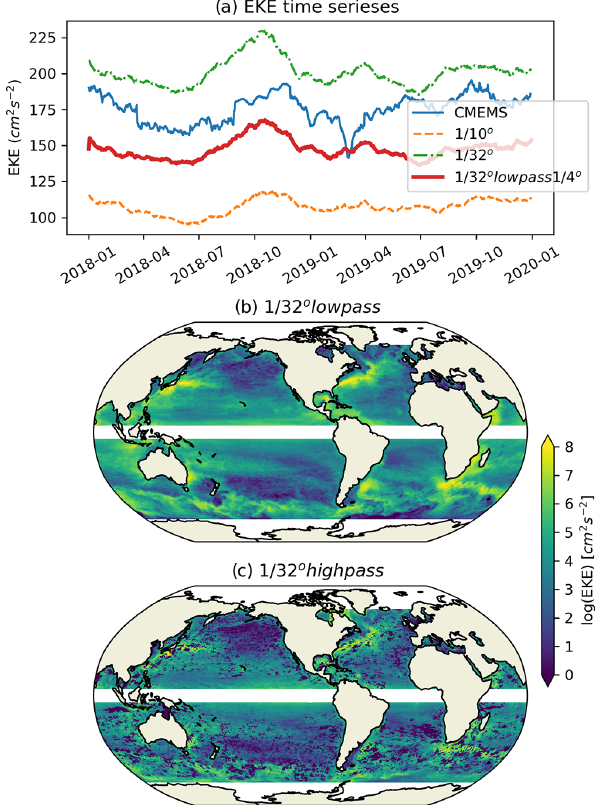
Figure 2. Time series of globally averaged EKE (a) , EKE of the 1 / 32 ◦ model filtered onto a 1 / 4 ◦ grid by a low-pass spatial filter with a radius of ∼ 50km (b) and the EKE residual as a high-pass component (c)